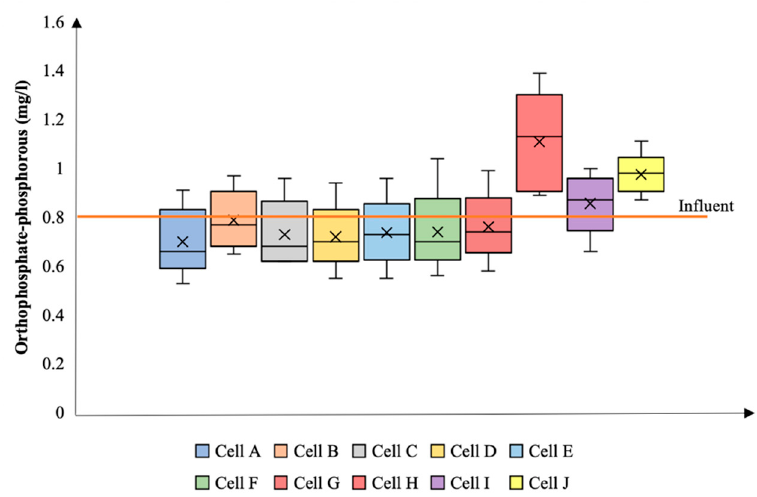
Figure 12. Concentration of orthophosphate-phosphorus. Sample number = 5; box plots show medians and 25th and 75th percentiles; whiskers represent the 10th and 90th percentiles.